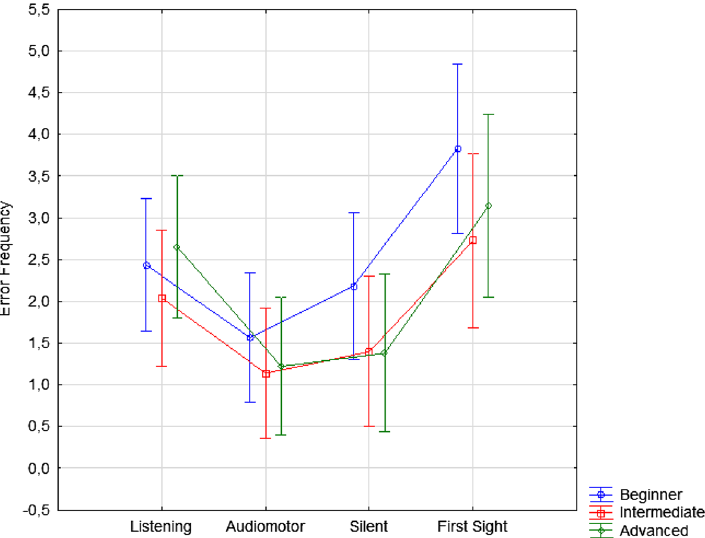
Figure 5. Error frequency observed for the two musical instruments as a function of error type (regardless of the students’ level and learning condition). Error bars indicate standard